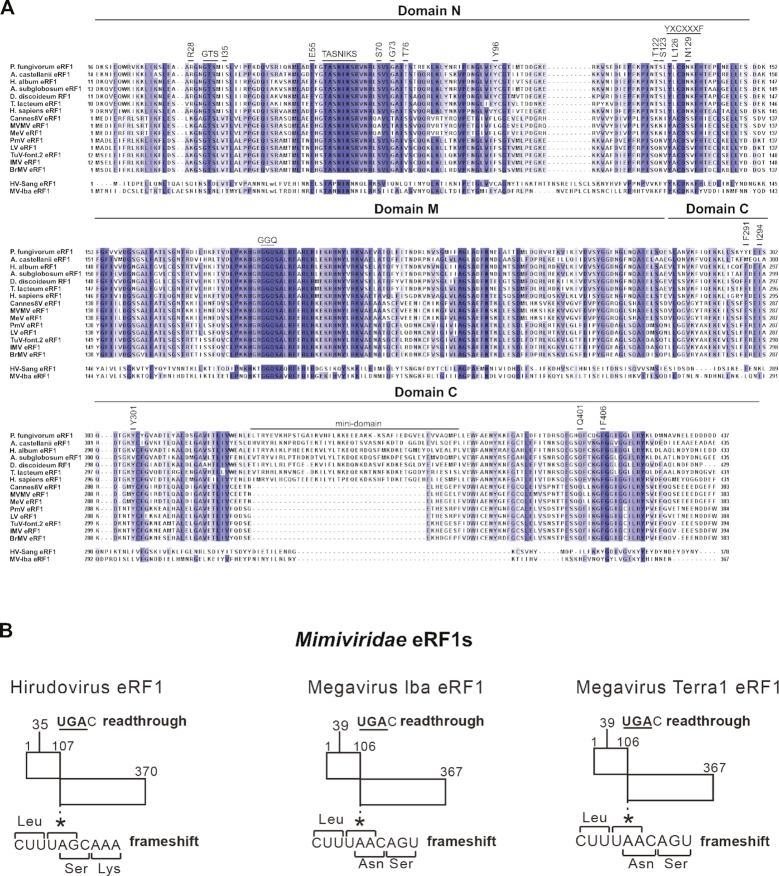
Multiple sequence alignment of eRF1 encoded by different eukaryotes and by giant viruses. (A) The alignment was made with Clustal W. NCBI accession numbers for the eukaryotic eRF1 proteins: H. sapiens (NP_004721), A. castellanii (XP_004338193), D. discoideum (XP_636638), P. fungivorum (PRP77657), H. album (XP_020437748), A. subglobosum (XP_012752976), T. lacteum (KYR01314). NCBI accession numbers for eRF1 encoded by giant viruses: Marseillevirus marseillevirus (MVMV) (ADB03912), Melbournevirus (MeV) (AIT54729), Cannes 8 virus (Cannes8V) (AGV01484), Tunisvirus fontaine2 (TuV-font.2) (AHC54787), Insectomime virus (IMV) (AHA46142), Port-miou virus (PMV) (ALH06844), Lausannevirus (LV) (AEA07018), Brazilian marseillevirus (BrMV) (AMQ10707), Hirudo virus strain Sangsue (HV-Sang) (AHA45107.1, AHA45106.1 and intervening/upstream sequences) and Megavirus lba (MV-lba) (AGD92187.1, AGD92188.1 and the intervening sequence). Domains (N, M, C and mini-domain), and the positions of conserved sequence motifs and amino acid residues involved in stop codon recognition and peptide release (GTS31–33, E55, TASNIKS58–64, YxCxxxF125–131, GGQ183–185) (H. sapiens residue numbering), amino acid residues responsible for eRF3 binding (F291, I294, Y301, Q397, Q401, F406) (H. sapiens residue numbering) (61), and amino acid residues that could influence eRF1’s stop codon decoding specificity (R28, I35, S70, G73, T76, Y96, T122, S123, L126, N129) (H. sapiens residue numbering) (62) are indicated. (B) Schematic representations of examples of Mimivirus eRF1 coding regions, showing the potential for synthesis of full-length proteins by the combination of readthrough of termination codons and frame-shifting.